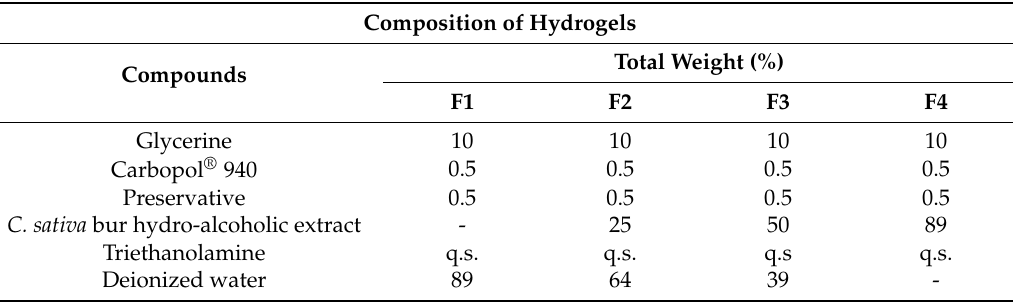
Table 1. Composition of the